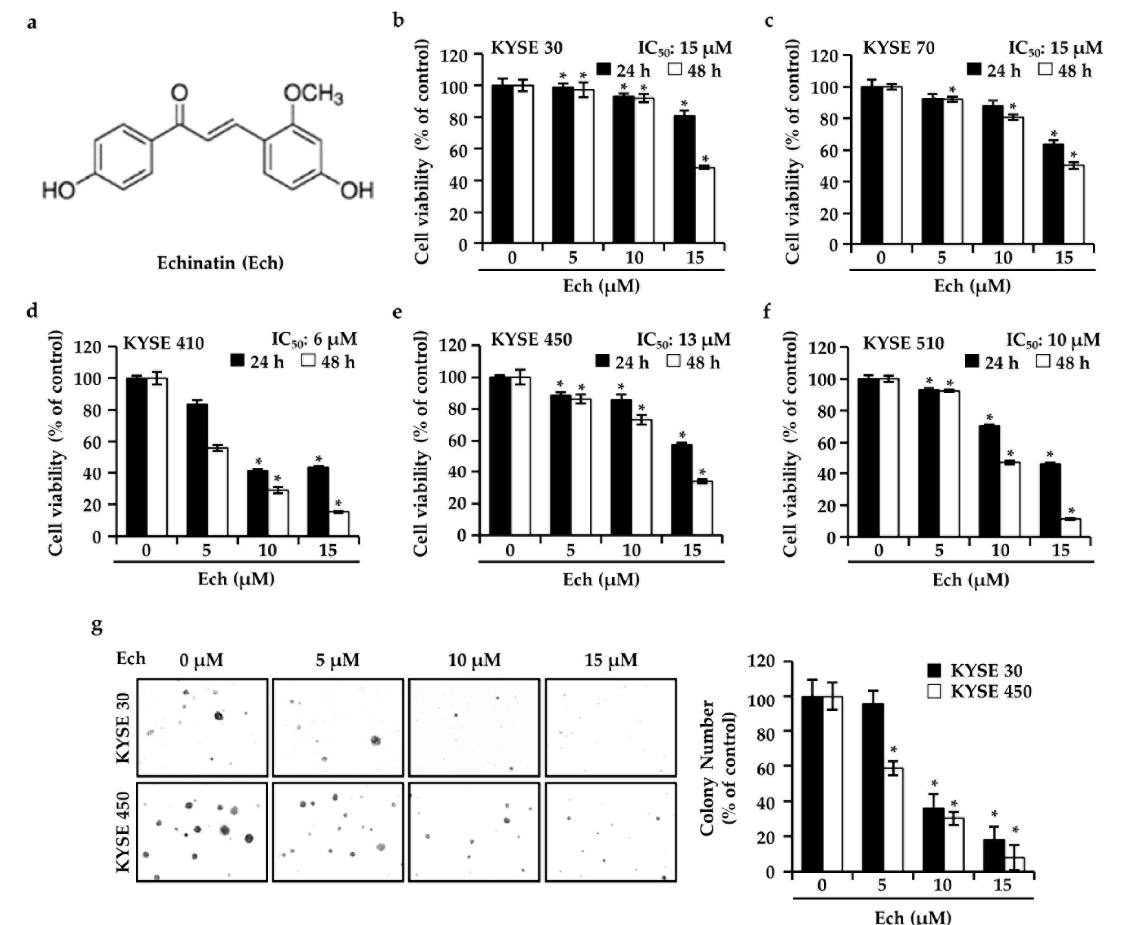
Figure 1. Effects of echinatin (Ech) on cell growth. ( a ) Structure of Ech. ( b–f ) Ech inhibited KYSE 30, KYSE 70, KYSE 410, KYSE 450, and KYSE 510 ESCC cells growth at 5, 10, or 15 µM for 24 h or 48 h. Cell viability was examined using MTT assay. ( g ) Representative pictures (left panel) and graph (right panel) of KYSE 30 and KYSE 450 cells colonies treated with Ech (0, 5, 10, 15 µM) for 14 days. Colonies were counted using a microscope. The graph shows the percentage compared to the control group. Data represent mean ± SD. Asterisk (*) denotes p < 0.05 compared to the control.